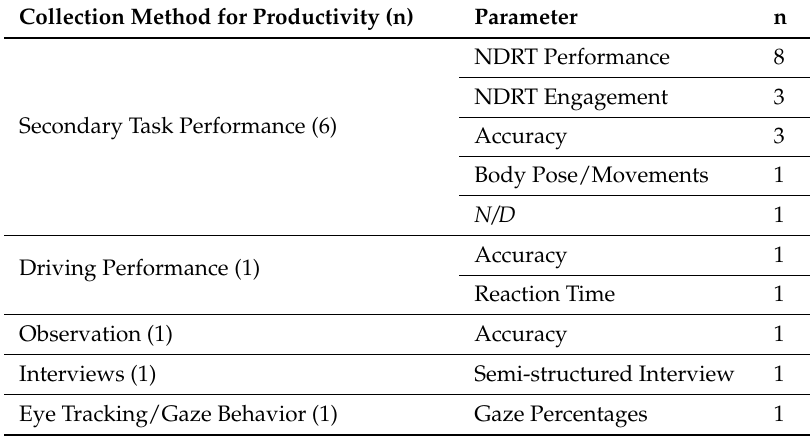
Table 12. Productivity collection methods and parameters.